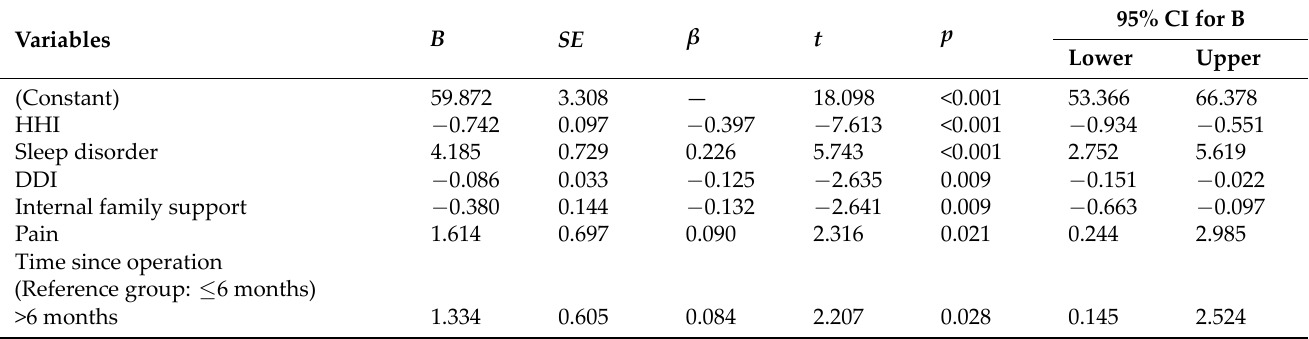
Table 4. Multiple linear regression model on correlates of CRF ( n = 363).